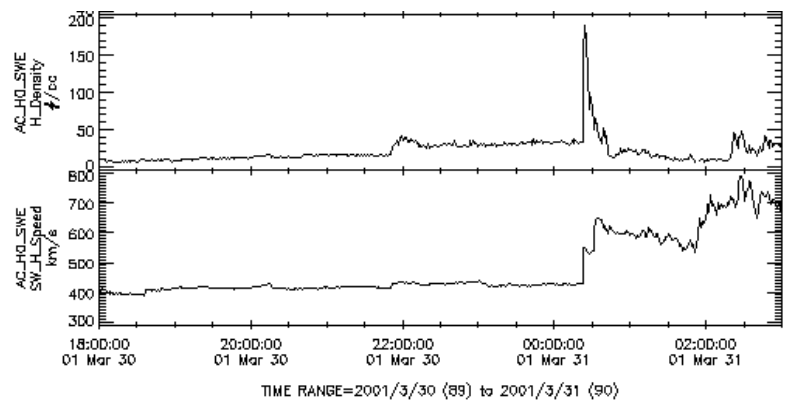
Fig. 10. Solar wind density and velocity values in the GSM coordinates measured at the ACE spacecraft. Horizontal axis shows UT hours from 18:00 UT on 30 March to 03:00 UT on 31 March.